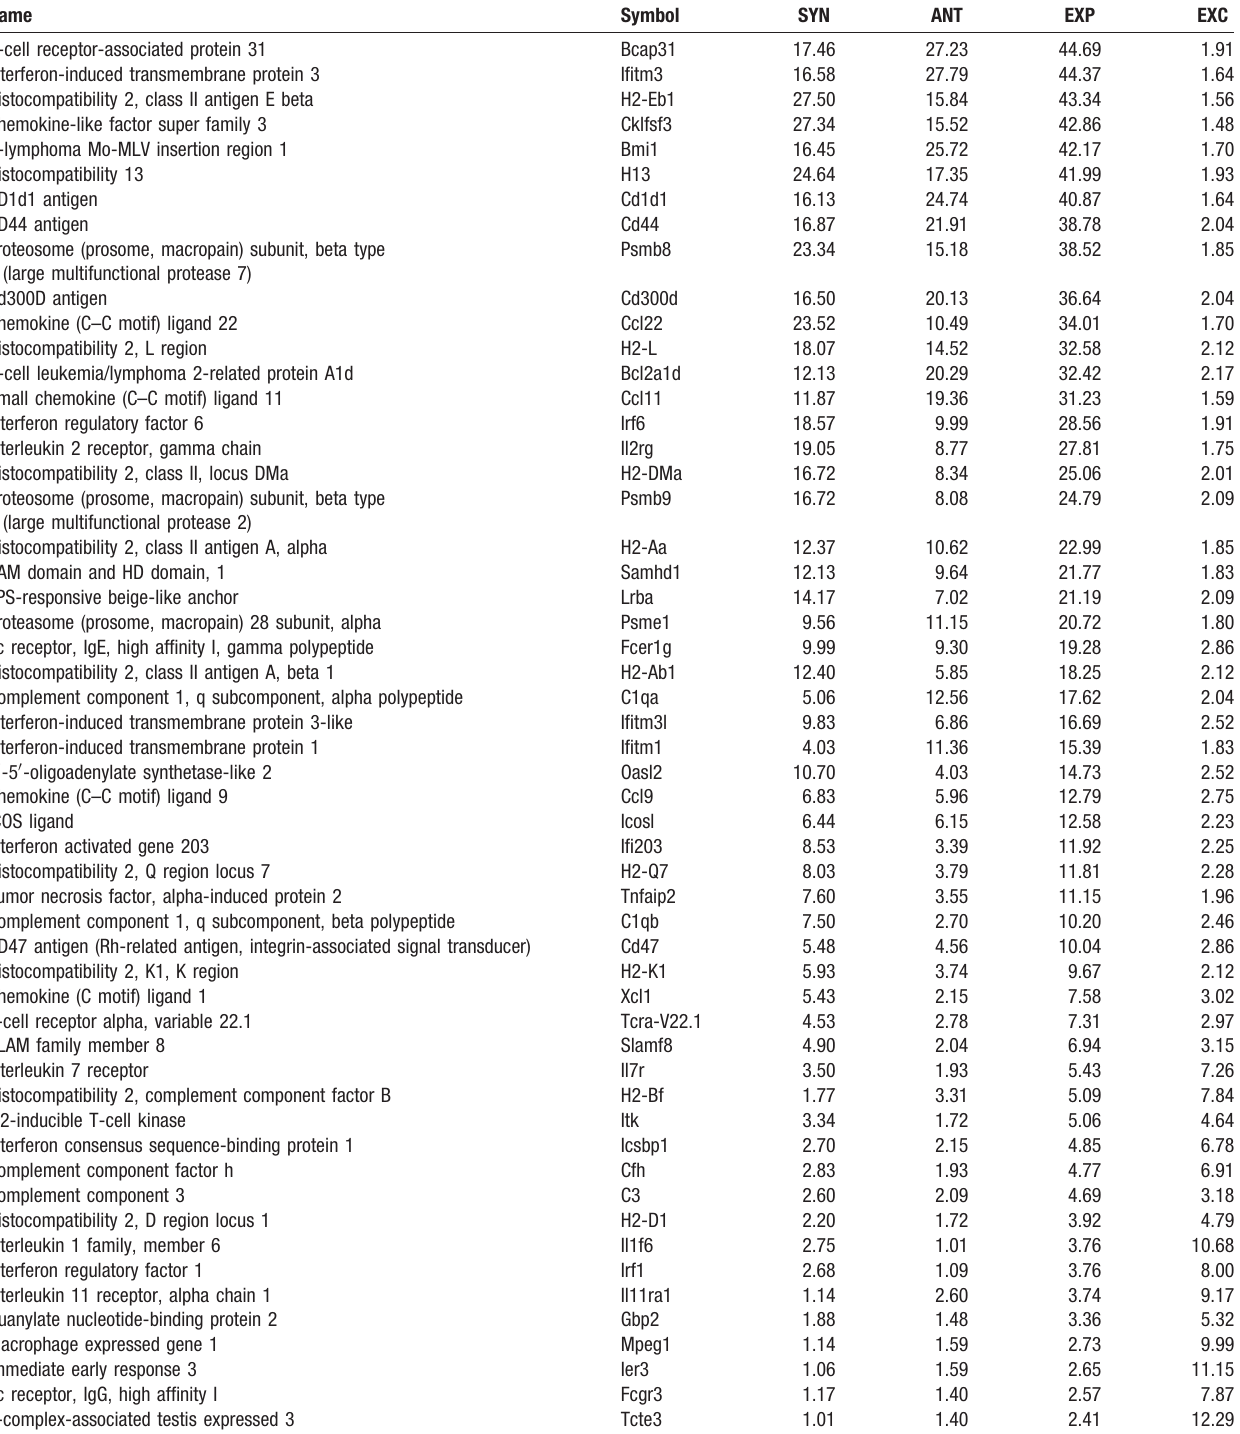
Table 5. The extent of the synergomes (SYN), antagomes (ANT), expresomes (EXP ¼ SYN þ ANT), and exclusomes (EXC) of the immune response genes in the control spinal